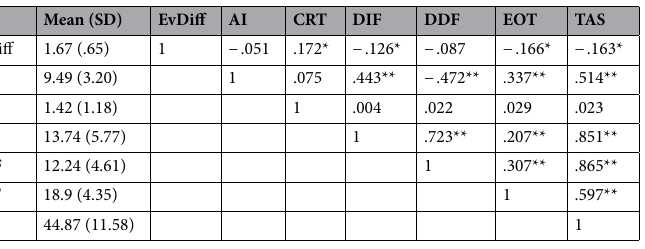
Table 2. Correlation coefficients (Spearman’s ρ) and descriptive statistics (mean and standard deviation) for all variables in Study 2. * indicates p < .05, ** indicates p < .001.